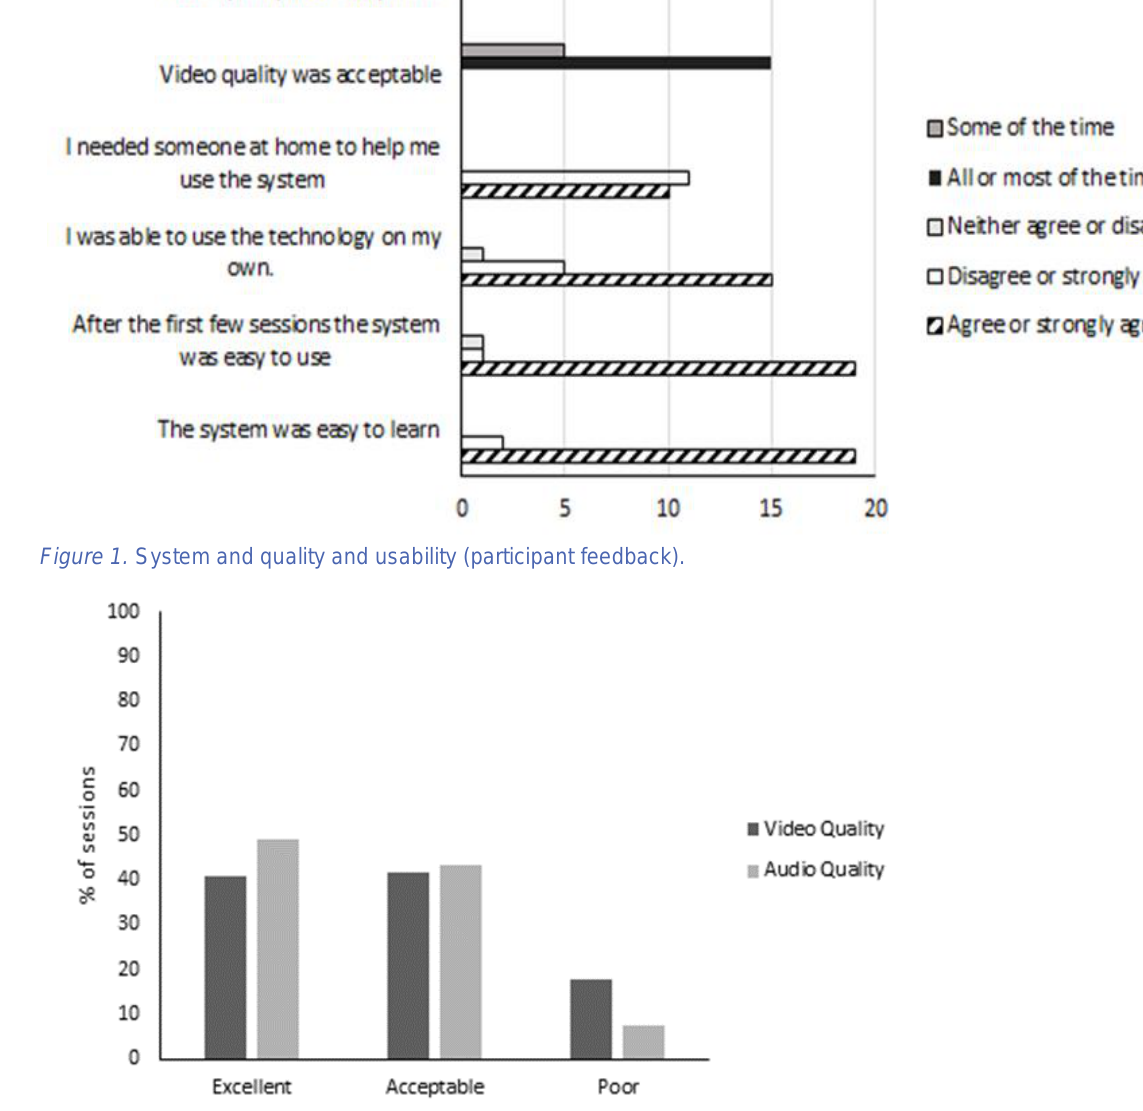
Figure 2. Video and audio quality rated by the exercise